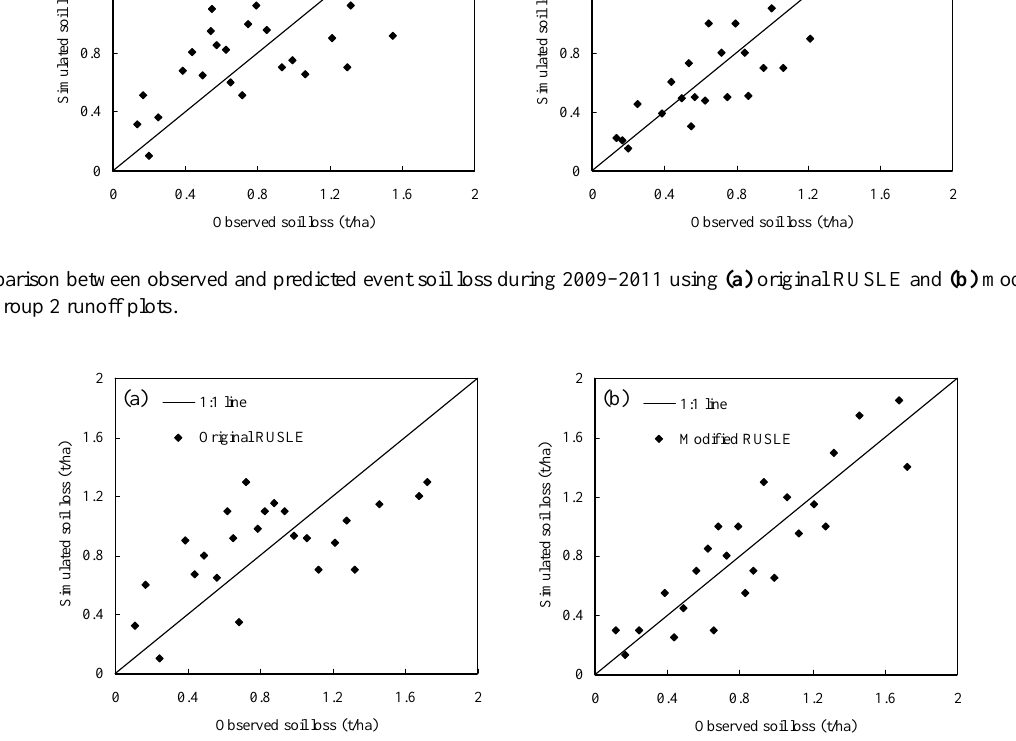
Fig. 9. Comparison between observed and predicted event soil loss during 2009–2011 using (a) original RUSLE and (b) modified RUSLE models for Group 3 runoff plots